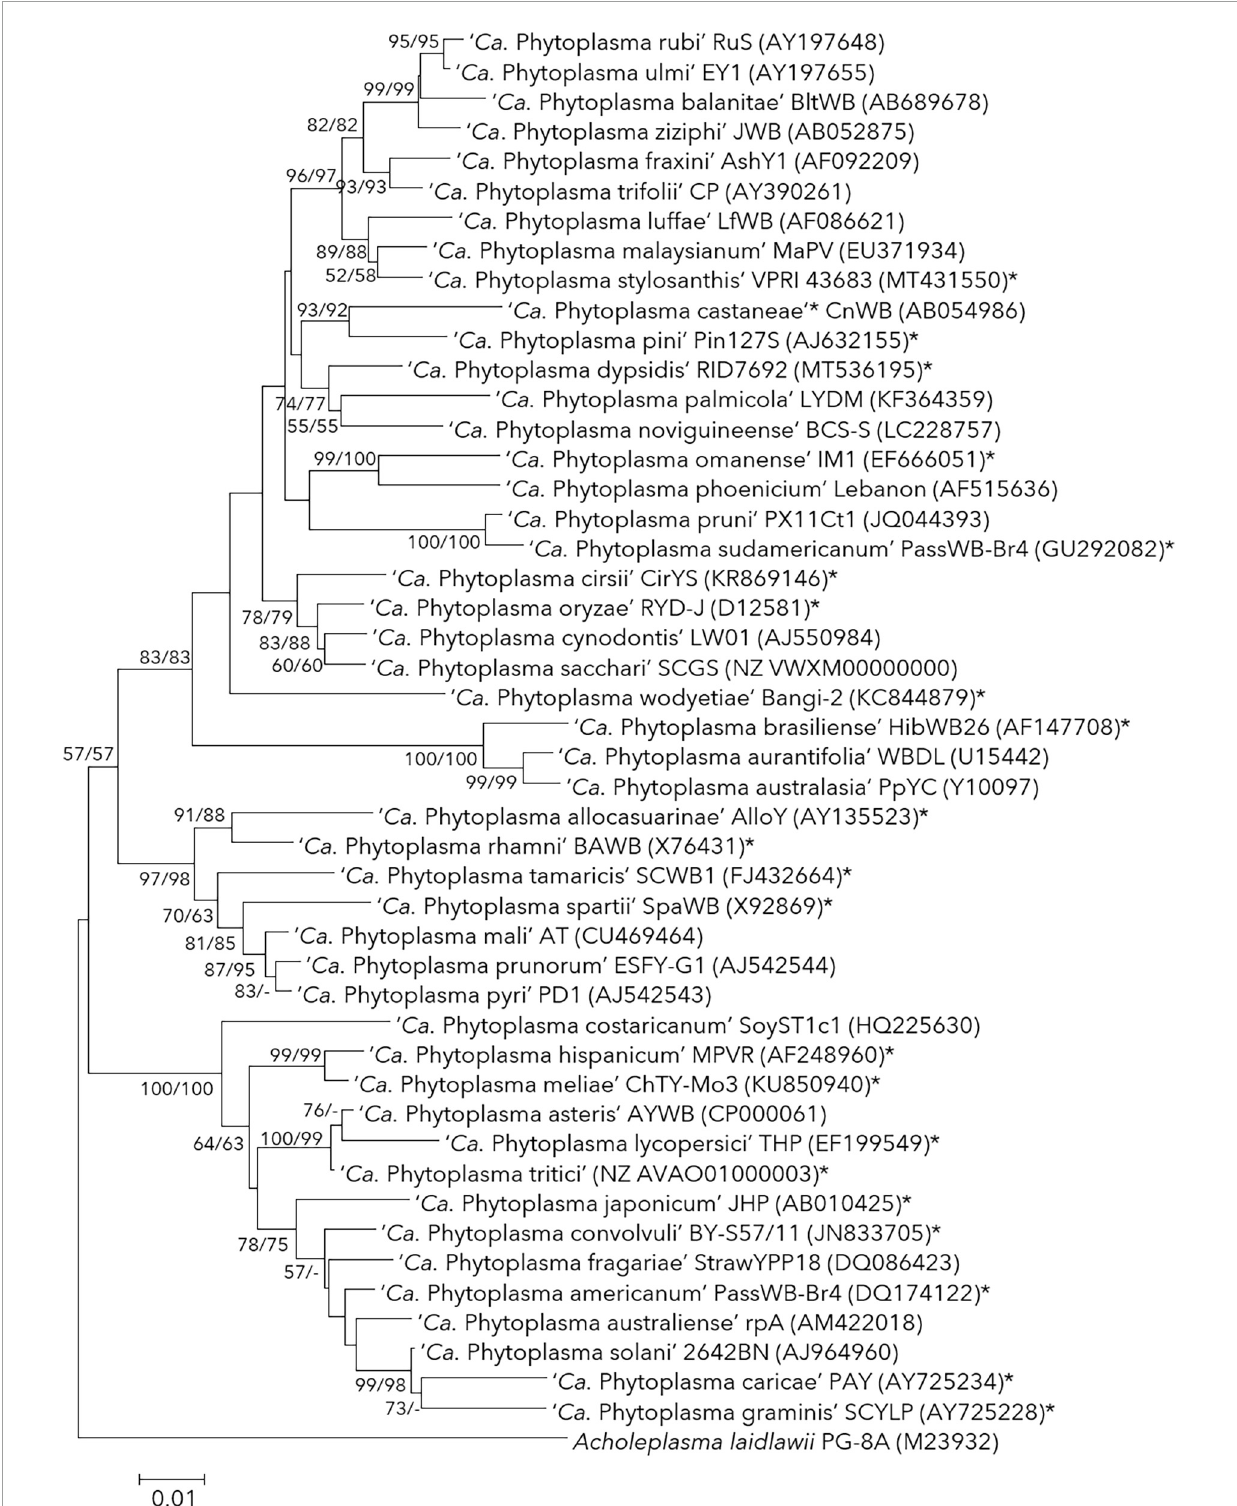
FIGURE1 Phylogenetic tree inferred from analysis of reference 16S rRNA gene sequences of published phytoplasma species. The neighbour-joining (NJ) and maximum-likelihood (ML) methods were used to build the phylogenetic tree building using MEGA 7 (Kumar et al., 2016). The topologies of the trees were evaluated by bootstrap analysis based on 1000 replicates. Figures at nodes ( > 50) of the branches indicate the percentage of replicate trees obtained from NJ and ML methods. The absence of a branch at a particular node was marked by ’- ’. There was a total of 976 positions in the final dataset. The 16S rRNA sequence of Acholeplasma laidlawii PG-8A (M23932) was used as an outgroup. Bar indicates the number of nucleotide substitutions per site. *Indicates orphan species described in